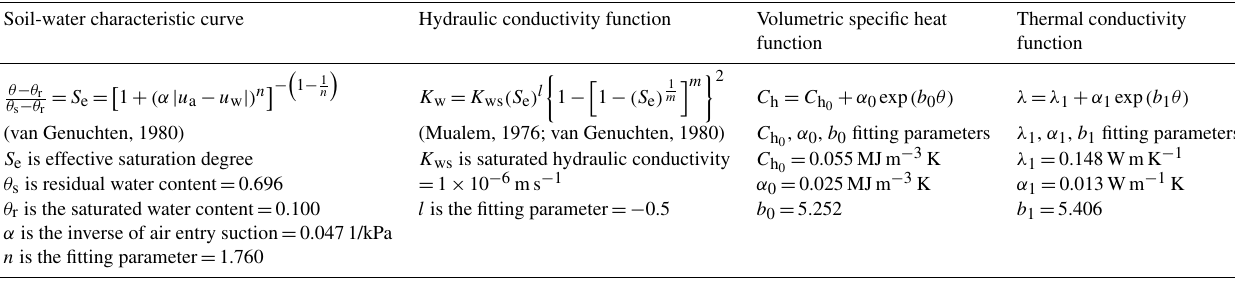
Table 1. Soil functions and estimated parameters for investigated soil.